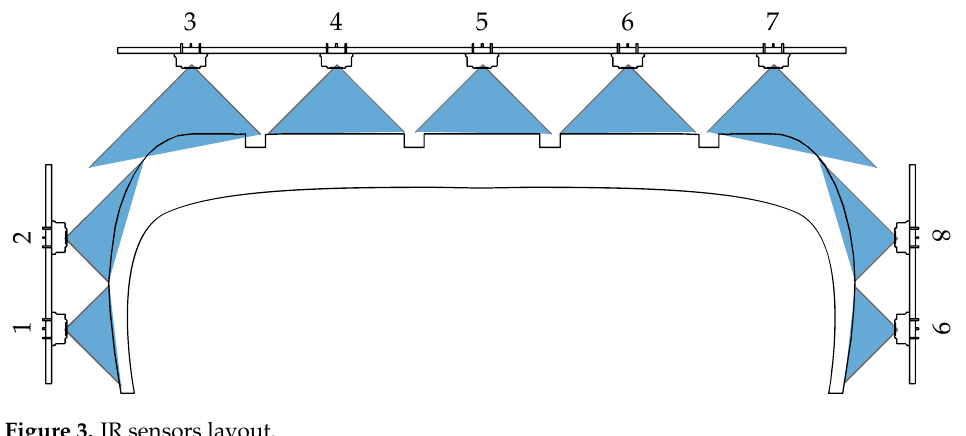
Figure 3. IR sensors layout. Table 1. Kistler RoaDyn P625 calibration certificate.